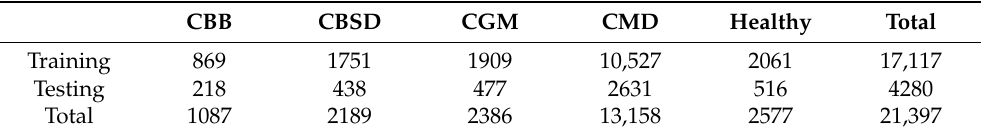
Table 2. Cassava leaf dataset detail.